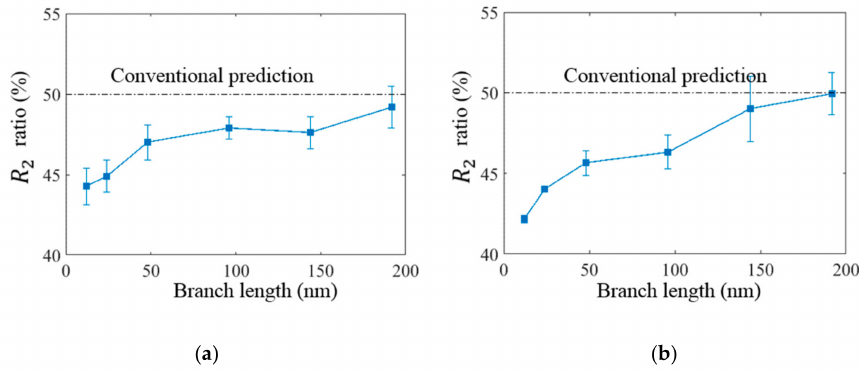
Figure 7. Branch length dependence of the heat current ratios inside branched CNTs with two T-junctions: ( a ) T-junction 1 and ( b ) T-junction